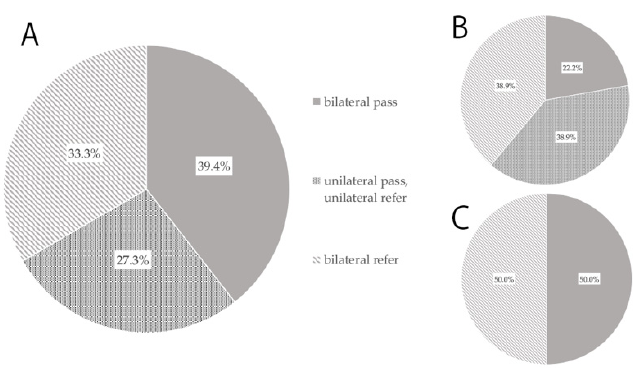
Figure 2. NHS survey of children with hearing loss due to cCMV infection. ( A ): Results of the 33 cases who underwent NHS. ( B ): Results of the 18 cases who underwent NHS by AABR. ( C ): Results of the six cases who underwent NHS by AOAE. The numbers indicate the percentage and the number of patients in parentheses.